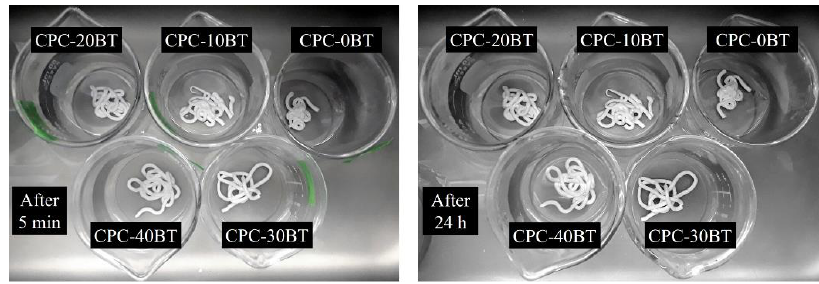
Figure 7. Washout resistance test of various CPC formulations in SLS.